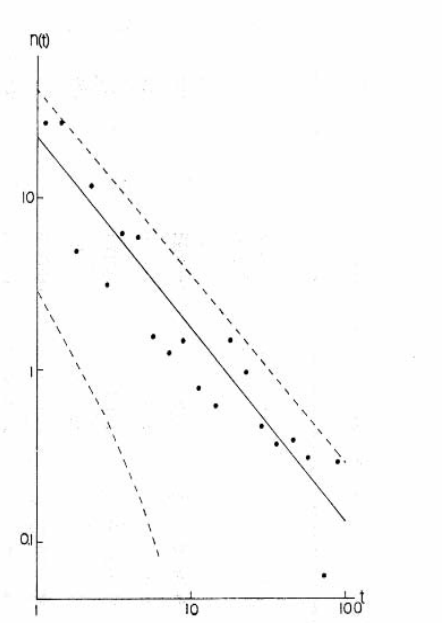
Figure 4. Time distribution of aftershocks: San Francisco 1957. Figure 5. Time distribution of aftershocks: Parkfield